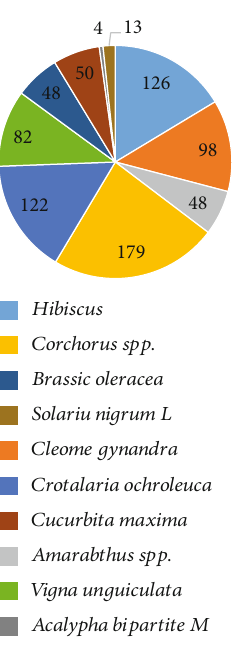
Figure 2: Vegetables most often used for medicinal